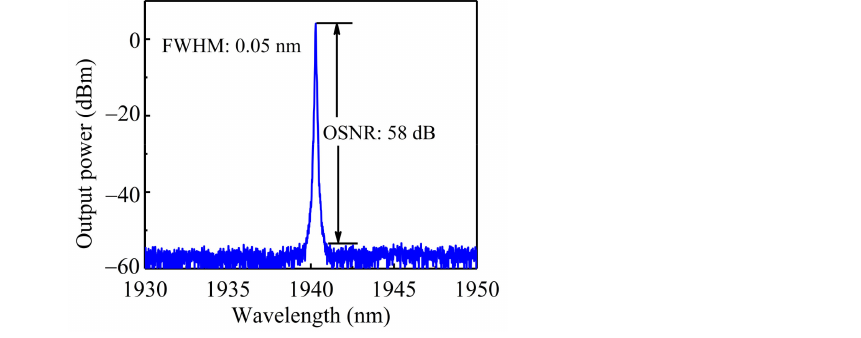
Figure 5. Optical spectrum of the thulium-doped fiber oscillator at an output power of 0.64 W.